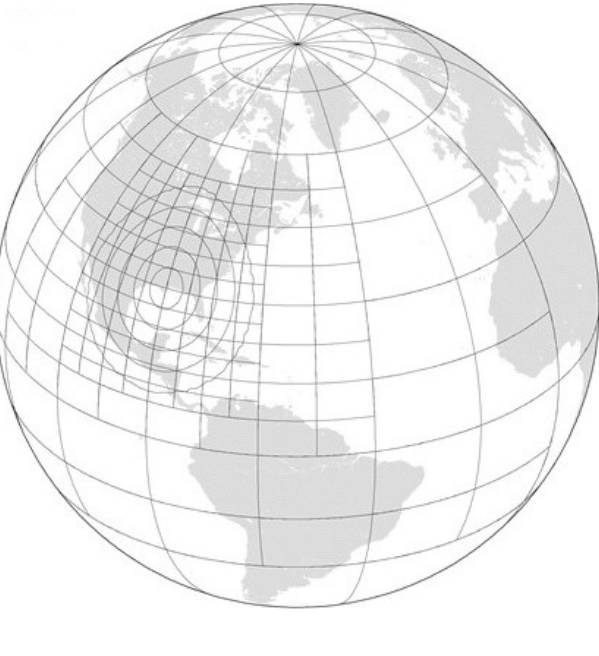
Figure 6. Block-structured adaptive grid on a global domain. Reprinted with permission from